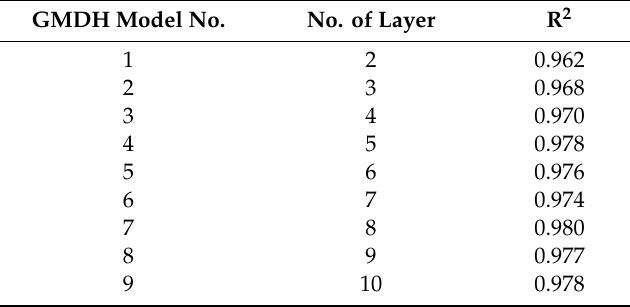
Table 5. The results of parametric study on the number of